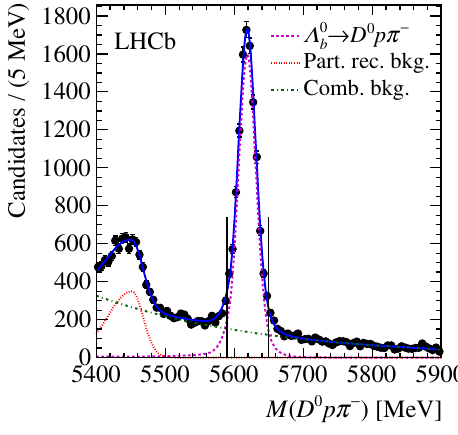
Figure 4 . Invariant mass distribution for the D 0 p(cid:25) (cid:0) candidates in the entire D 0 p(cid:25) (cid:0) phase space. The blue solid line is the (cid:12)t result. Signal, partially reconstructed and combinatorial background components are shown with di(cid:11)erent line styles. Vertical lines indicate the boundaries of the signal region used in the amplitude (cid:12)t.